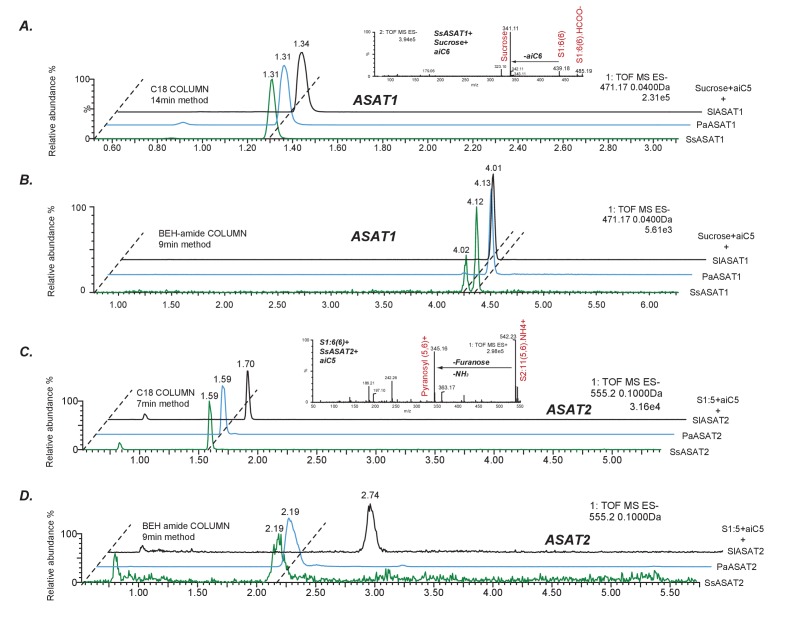
Comparative analyses of LC/MS retention times of enzyme reaction products.(A,B) Comparison between S1:5(5) produced by SsASAT1, PaASAT1 and SlASAT1 on the C18 (A) and the BEH amide (B) column. The dashed line connect the peaks aligned based on their retention times, and shows that the SsASAT1 product peaks align precisely with the PaASAT1 product peaks with two different chromatographic methods (A,B), suggesting structural identity. (C,D) Comparisons between SsASAT2, PaASAT2 and SlASAT2 enzymes similar to those shown above, suggest that SsASAT2 and PaASAT2 acylate the same positions on the sucrose molecule. Inset in (A) shows negative ion mode fragmentation of S1:6(6) product of the SsASAT1 reaction using aiC6 CoA as donor. Inset in (C) shows positive ion mode fragmentation of S2:11(5,6) product of SsASAT2 using S1:6(6) produced by SsASAT1 as substrate. Inset in (C) shows that both aiC5 and aiC6 are added on the same (pyranose) ring.